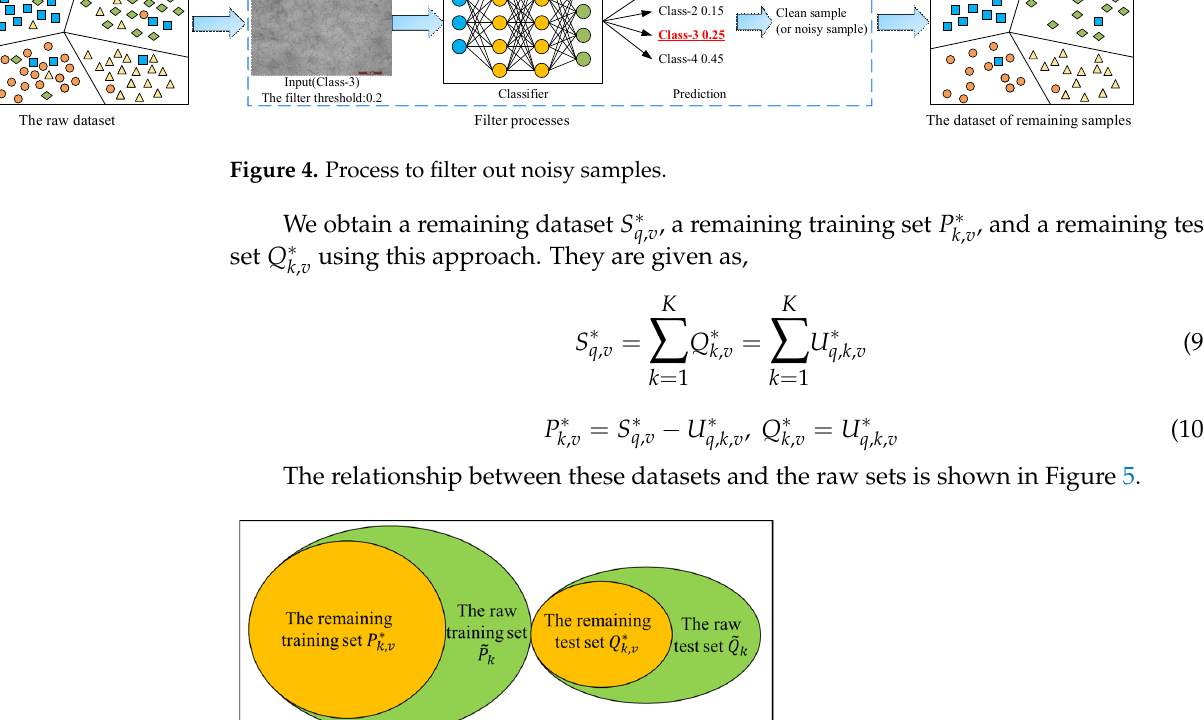
Figure 5. Relationship between the raw sets and the remaining sets. The remaining training set and the raw test set are used during retraining. The same test set is always used throughout the